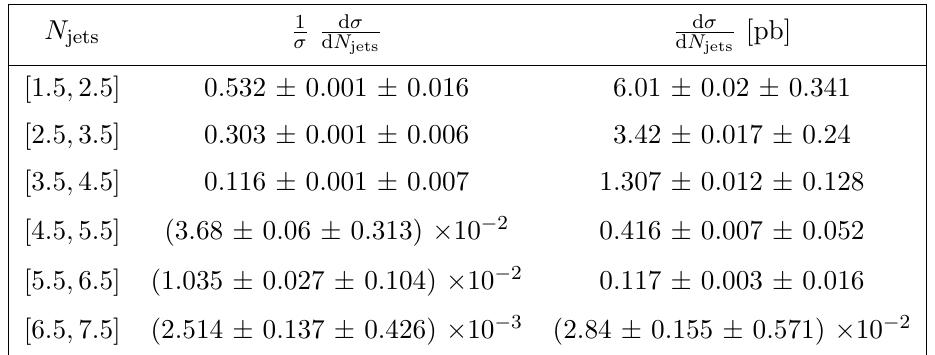
Table 47 . The measured di(cid:11)erential cross section and bin boundaries for each bin of the normalized and absolute measurements of the tt di(cid:11)erential cross section at particle level in the (cid:12)ducial phase space as a function of N jets are tabulated.